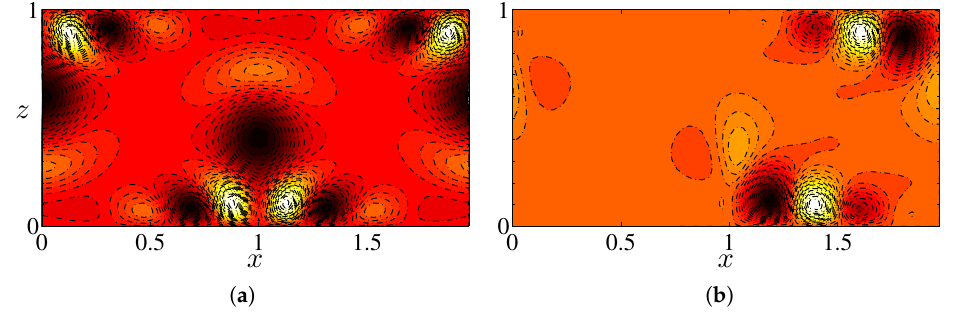
Figure 9. The fastest-growing 2D temperature eigenfunctions at Ra = 500, L s = 2 and β = 0. ( a ) φ = 0 ◦ ; ( b ) φ = 20 ◦ . For the horizontal case, reflection symmetry is satisfied and both the natural and antinatural rolls are equally unstable. However, as φ is increased, the natural roll is stabilized and the instability of the antinatural roll is intensified.